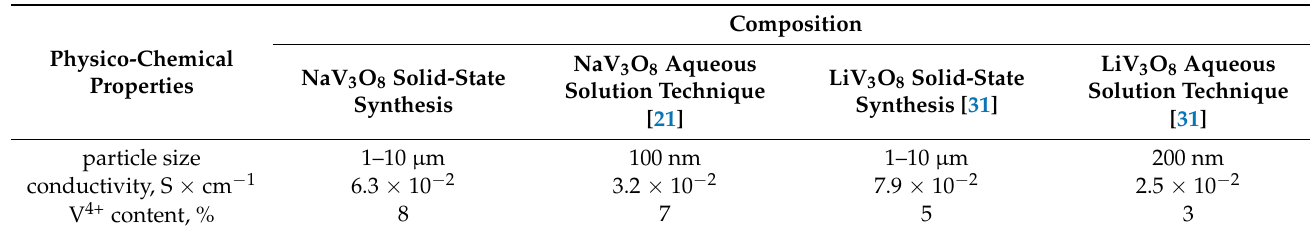
Table 1. Data on the physico-chemical properties of the sample NaV 3 O 8 produced by solid-state synthesis obtained in this work and sample NaV 3 O 8 produced by aqueous solution technique [21] compared to similar sample LiV 3 O 8